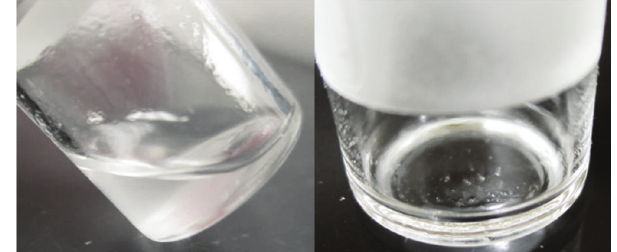
Figure 8: White solid observed in partially degraded DFP.